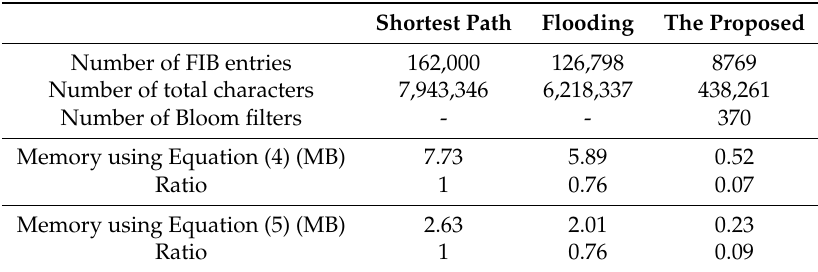
Figure 10. Comparison in the normalized number of Interest packets. The proposed scheme uses only about 1% more Interest packets than the shortest path , while simple flooding consumes up to almost twice the number of Interest packets. Table 2. Memory consumption of AS-1775.